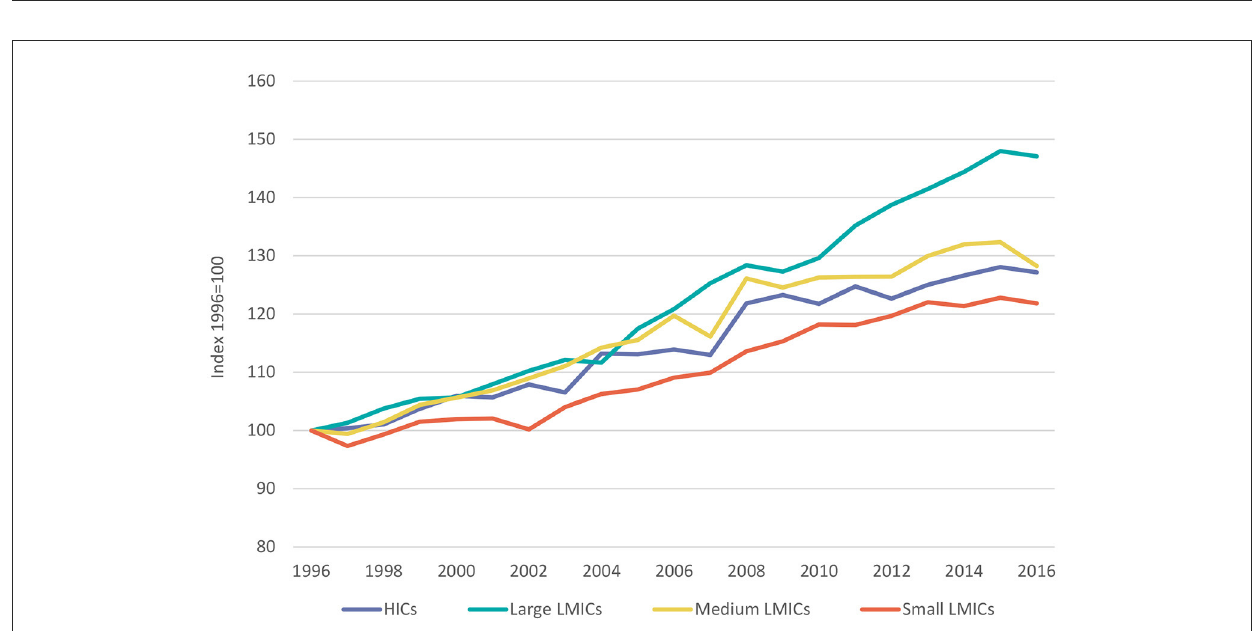
FIGURE4 TFP growth in HICs and LMICs with large, medium, and small agricultural research system, 1996–2016. Sources: Elaborated by authors based on Agricultural Science and Technology Indicators (2022) and United States Department of Agriculture, Economic Research Service (2022). The size